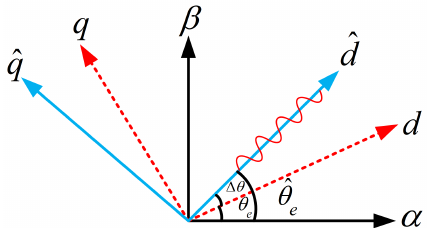
Figure 12. HF d-axis pulsating voltage for the signal injection [41].